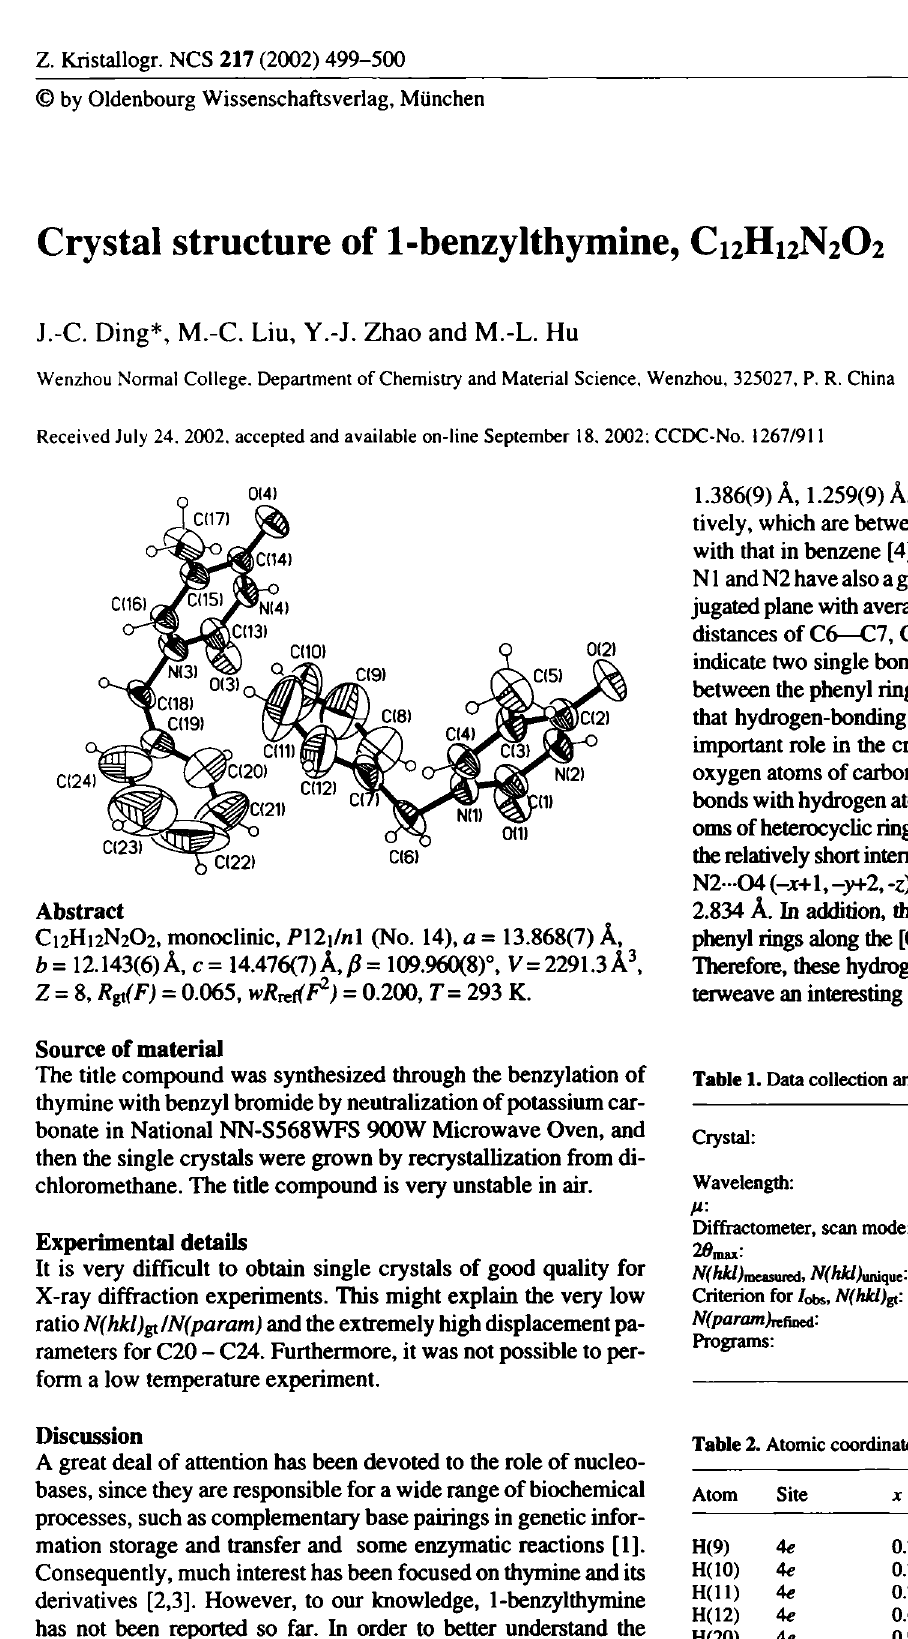
Table 2. Atomic coordinates and displacement parameters (in A 2